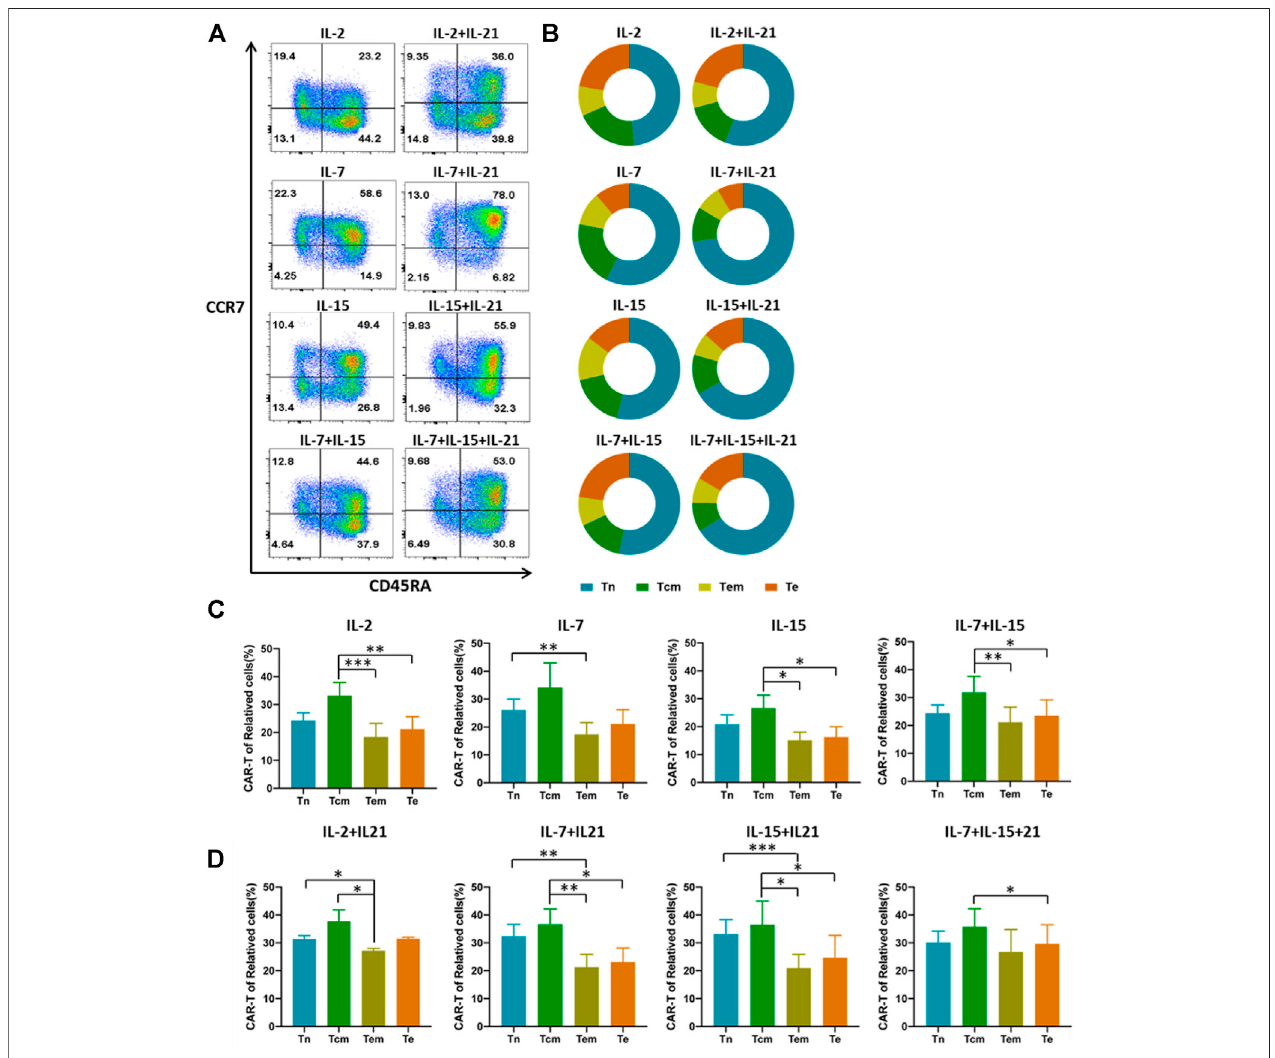
FIGURE 3 | IL-21 affects the proportion of different CAR-T cell subtypes. (A,B) Differentiated subtypes of HER-2 CAR-T cells were measured with surface expression of CD45RA and CCR7 on day 12 after transduction by fl ow cytometry. Tn:CD45RA + CCR7+, Tcm:CD45RA-CCR7+, Effector memory T cells (Tem): CD45RA-CCR7 − , Effector Tcells (Te): CD45RA + CCR7 − , Resultsfrom fl ow plots of one representativedonor and summary data for indicated CAR-T cell groups were shown. (C,D) CAR expression of different cell phenotypes was shown with percentage of CAR + cells out of the corresponding subtypes. Error bars represent ± SEM. Statistical signi fi cance was tested using Student ’ s t -test (* p < 0.05, ** p < 0.01, *** p < 0.001).